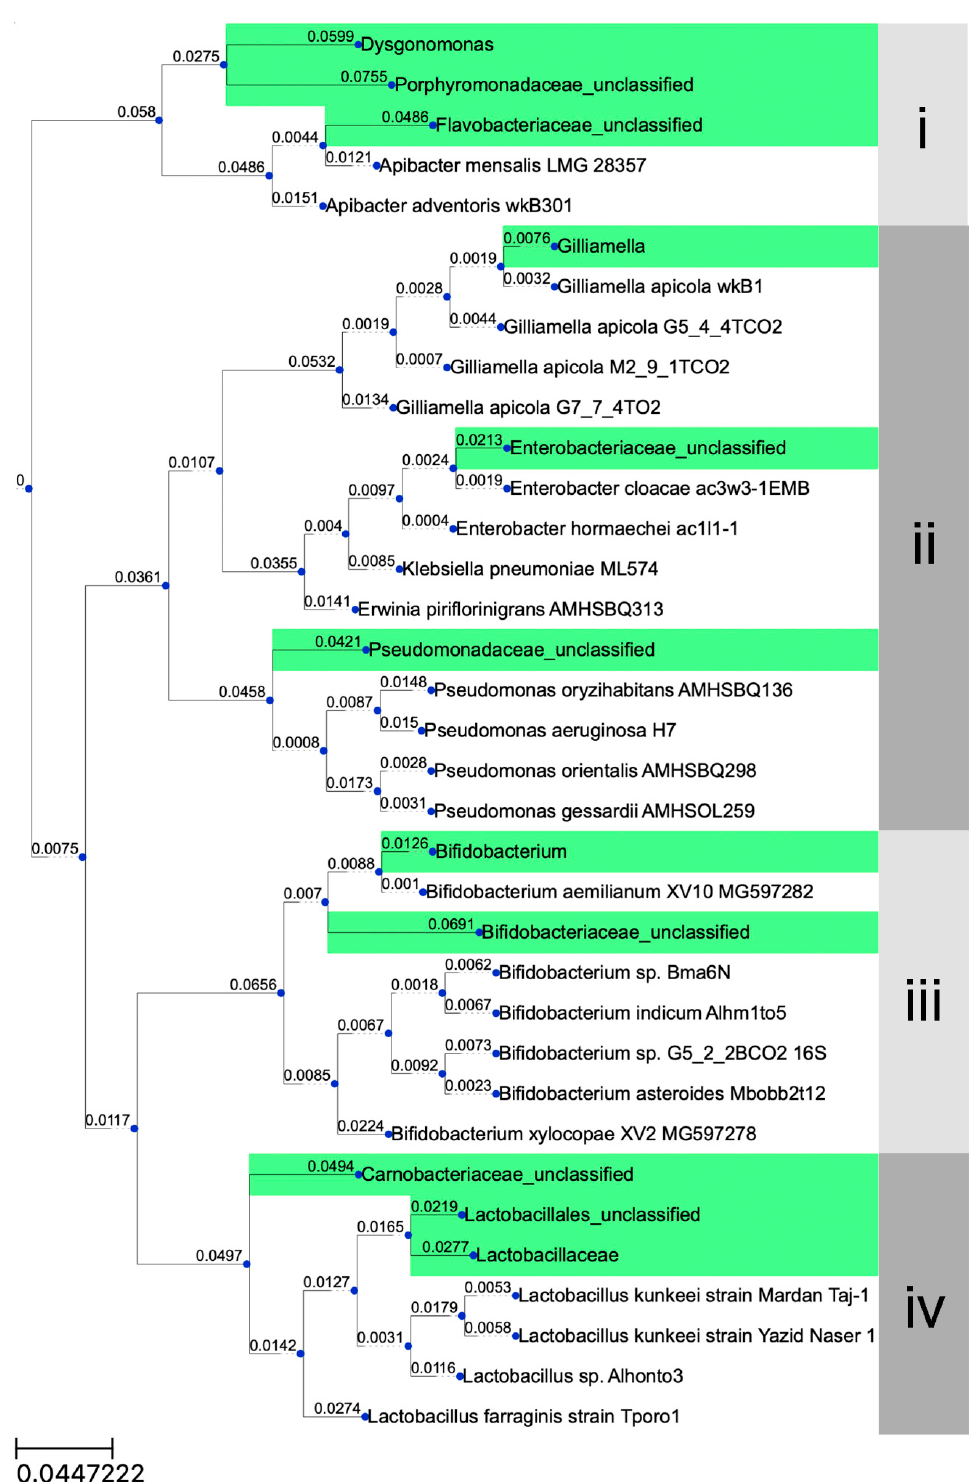
Figure 6. Multiple sequence alignment was performed using webPRANK, the phylogeny-aware algorithm which was suitable for aligning the gapped sequences. The length and the number of each tree branch represent the distance, as the scale bar shows the distance length of each